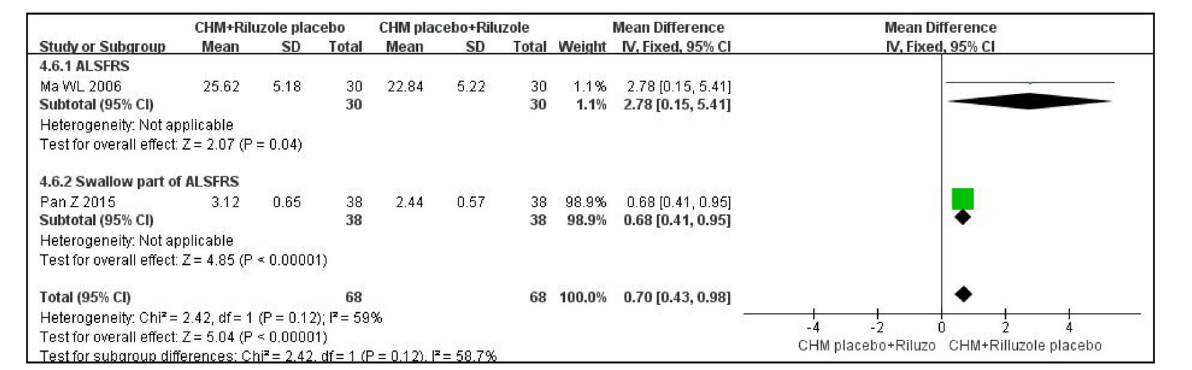
FIGURE1 Forest plot of ALSRF for ALS compared CHM with controls. ALSFRS, ALS functional rating scales; CHM, Chinese herbal medicine; ALS, amyotrophic lateral sclerosis.